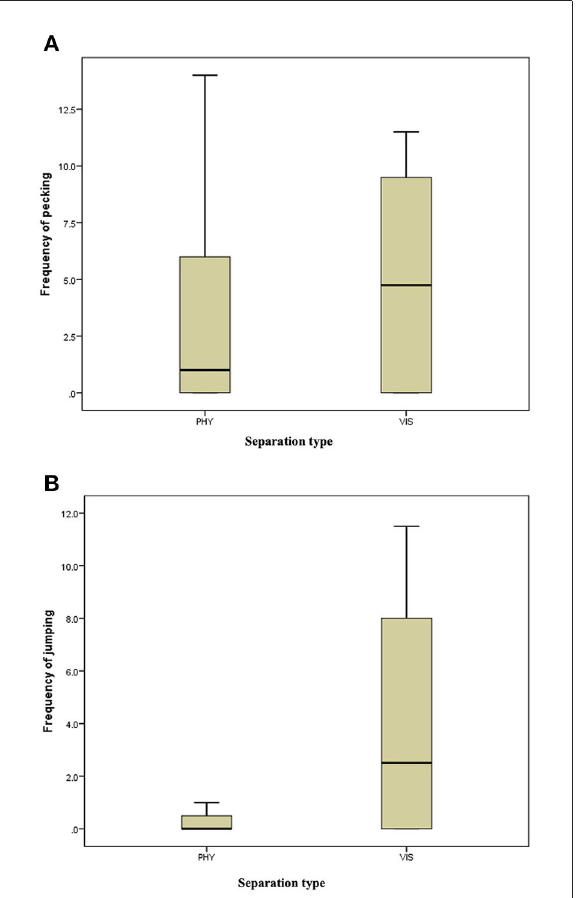
FIGURE6 (A) Frequency of pecking of the mother hens when subjected to 10-minute physical (PHY) or visual (VIS) separation from their chicks. (B) Frequency of jumping of the mother hens when subjected to 10-minute physical (PHY) or visual (VIS) separation from their